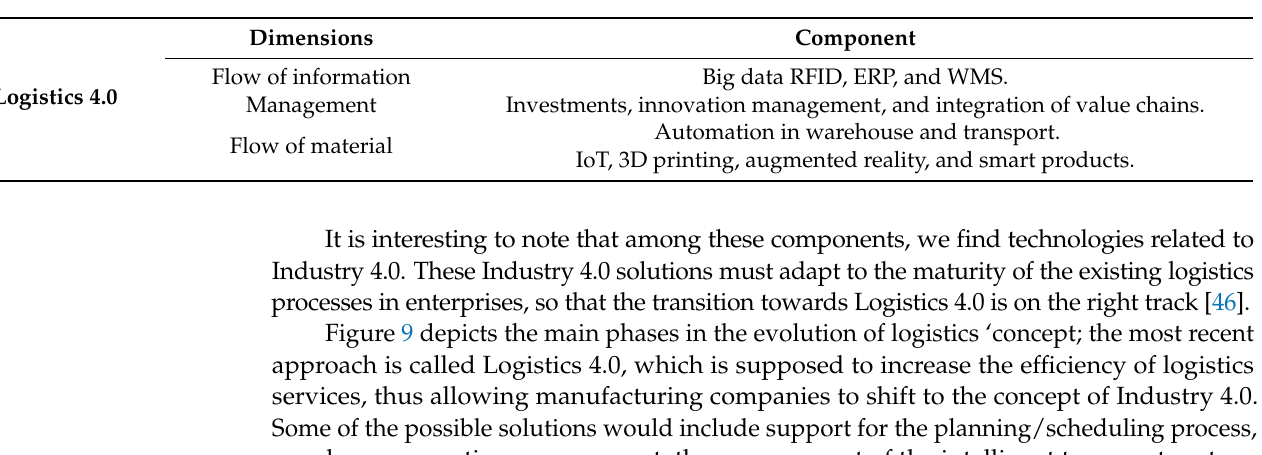
Table 7. Logistics 4.0 dimensions